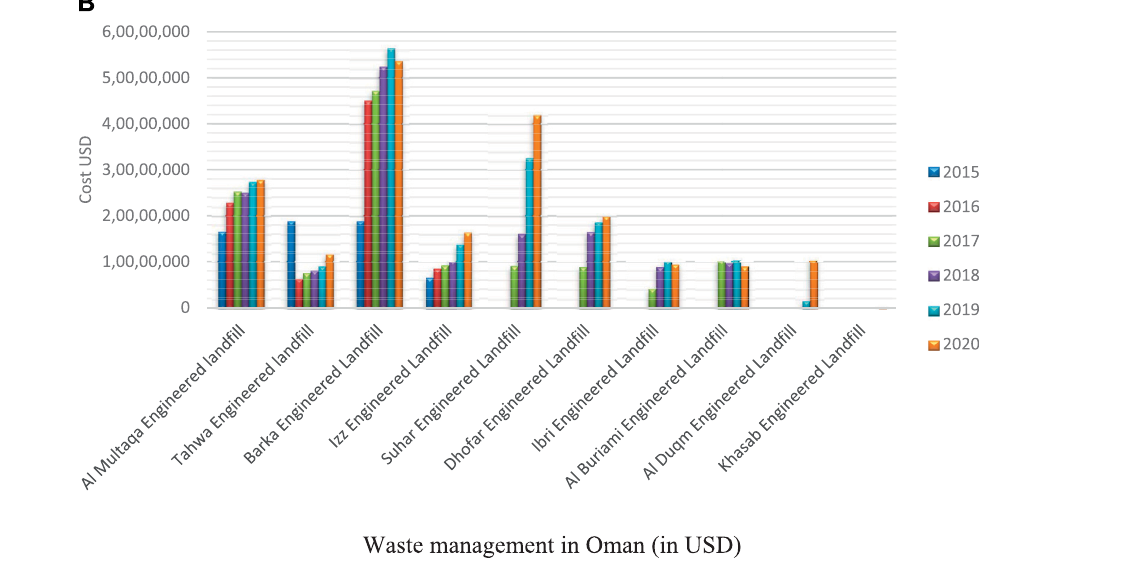
Frontiers in Bioengineering and Biotechnology |